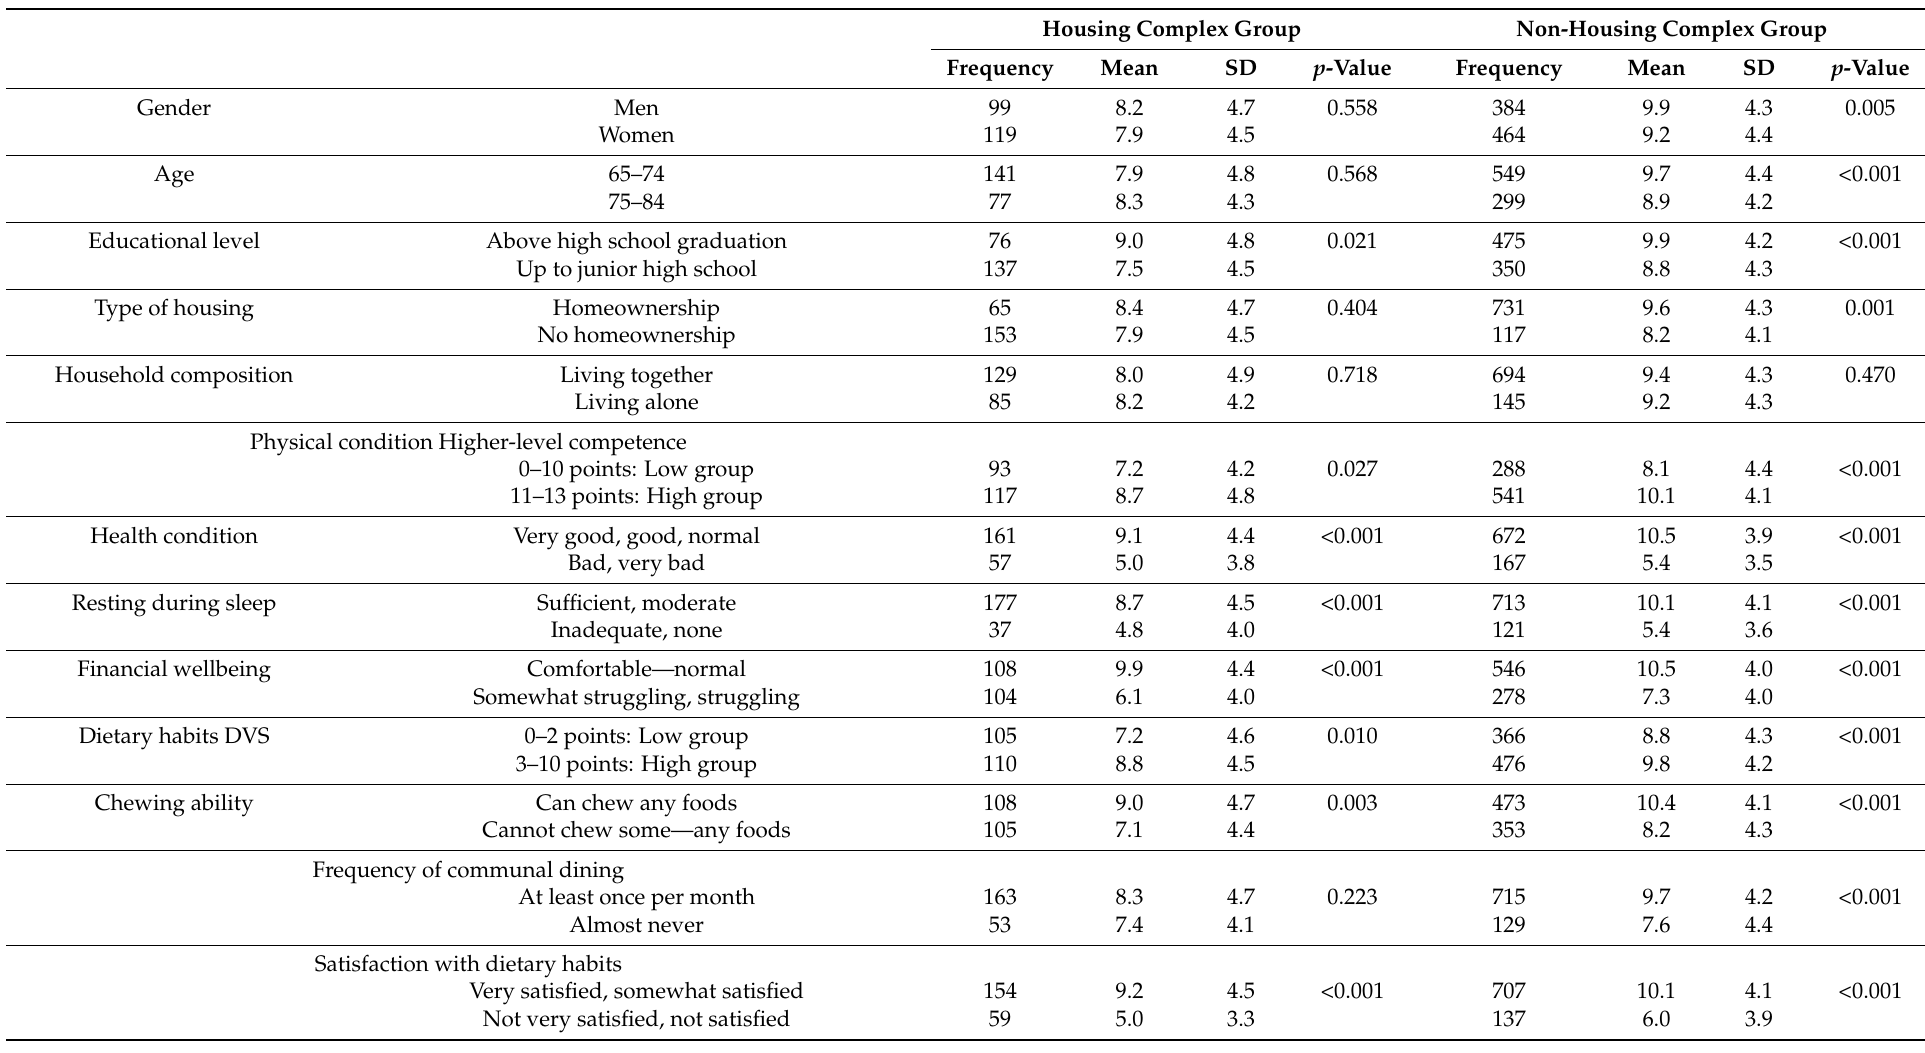
Table 2. Results of univariate analysis of independent variables and subjective wellbeing (PGCMS